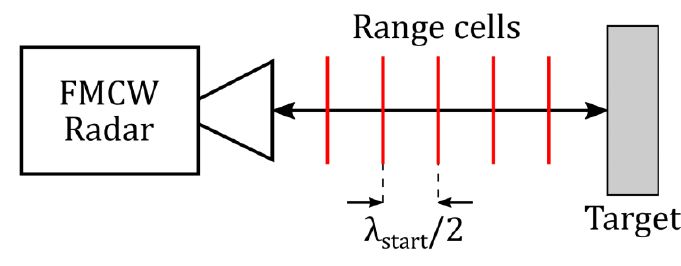
Figure 4. Range cell concept .